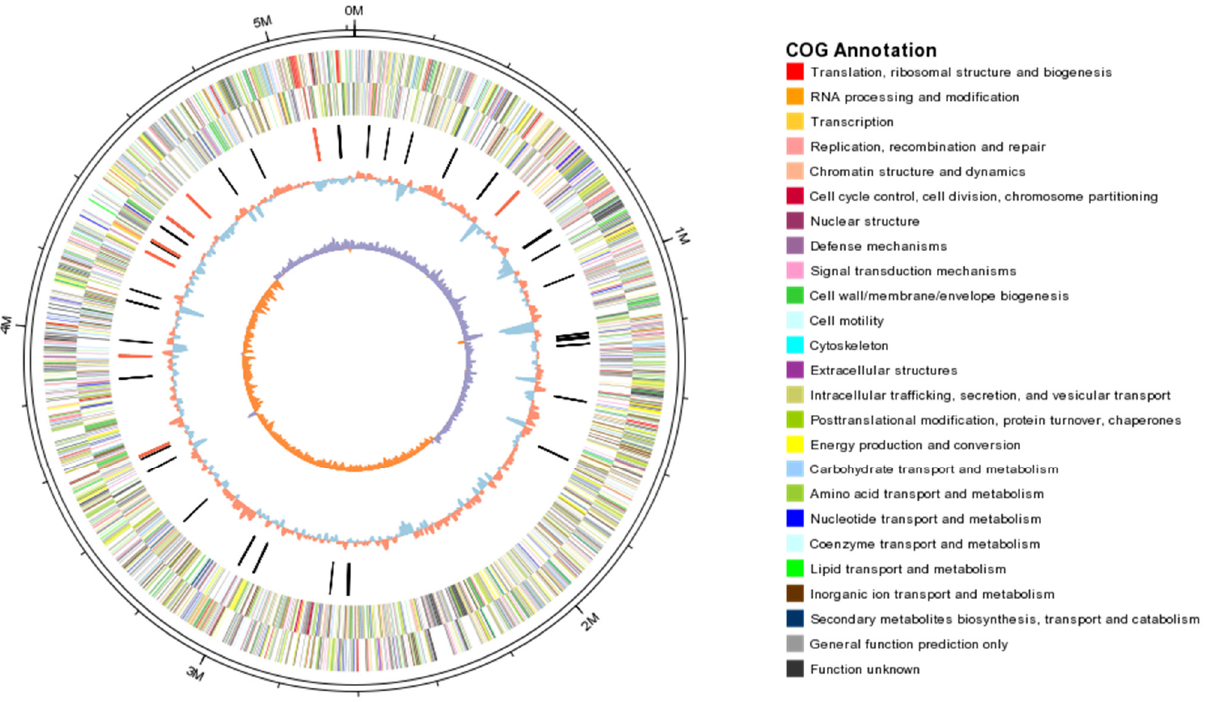
Figure 1. Circular map of the chromosome of K. pneumoniae KpC4. From the outside in, the first and second circles show the predicted protein-encoding regions on the plus and minus strands, by role, using the colors for the COG functional categories (http://www.ncbi.nlm.nih.gov/COG/grace/fiew.cgi (accessed on 3 July 2020)). The third circle shows tRNA (black) and rRNA (red). The fourth circle shows the GC content (red indicates > mean value, blue indicates < mean value). The fifth circle shows the GC skew (GC skew = (G − C)/(G + C); purple indicates > 0, orange indicates < 0). Table 1. General features of the KpC4 genome and related